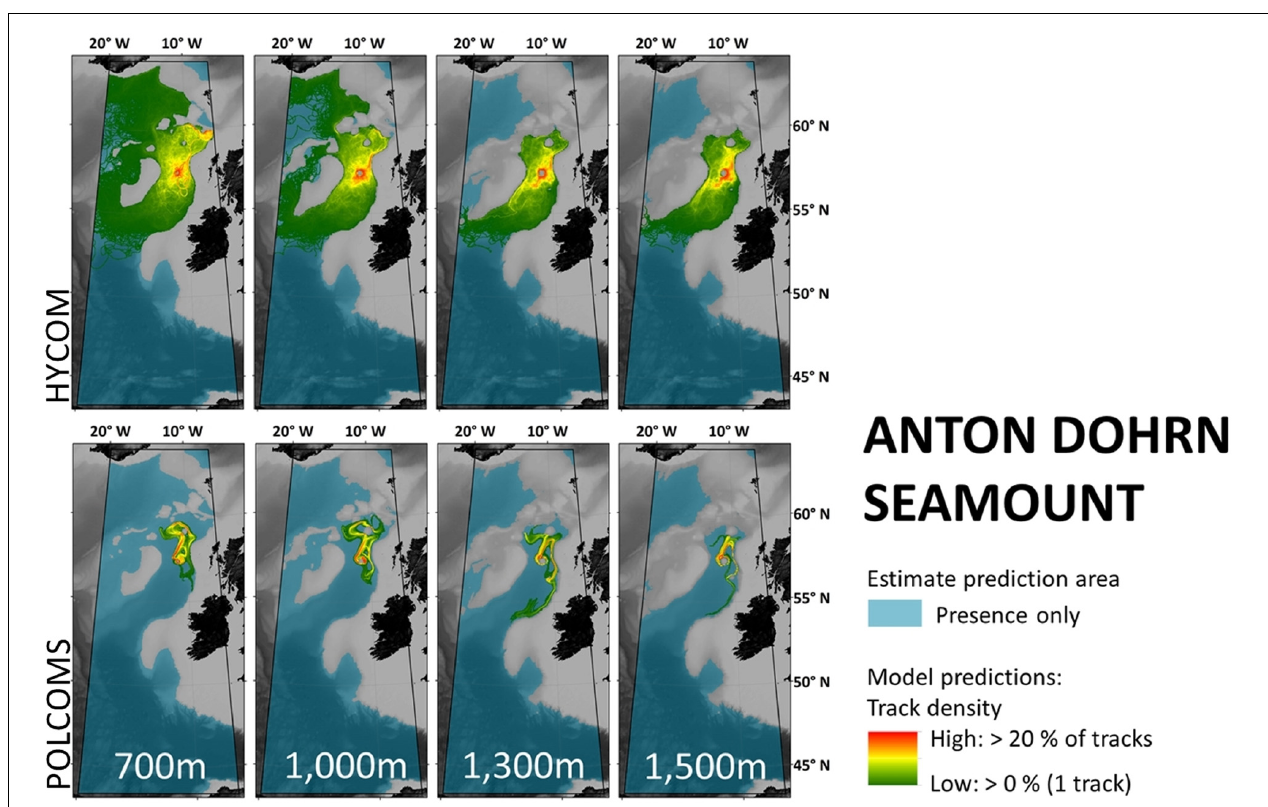
FIGURE 4 | Maps per depth band of predicted larval dispersal as simulated from Anton Dohrn Seamount. Simulations from HYCOM and POLCOMS models are displayed as track densities delineating between occasional and persistent pathways of dispersal. All estimate prediction areas fill the POLCOMS domain but differ between maps due to the 2D nature of simulations excluding areas of raised topography. Spatial correlations were conducted comparing the extent of modeled and estimated predictions and the extent and density information of each modeled prediction ( Table 2 ). [All maps were created in ArcGIS 10.3 (http://www.esri.com) with GEBCO 30 arc-second topography, available from www.gebco.net, and projected using Albers Equal Area Conic with modified standard parallels and meridian (sp 1 = 46 ◦ N, sp 2 = 61 ◦ N, m = 13 ◦